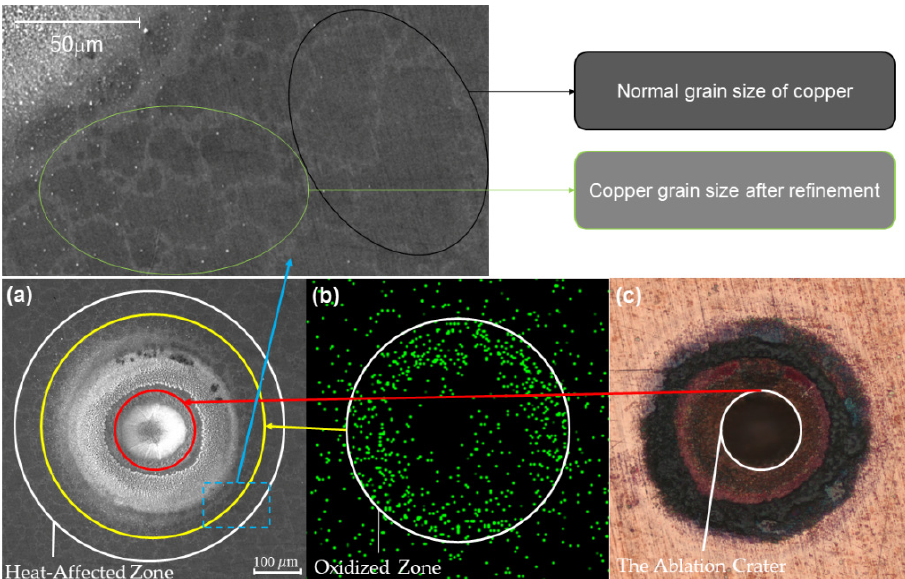
Figure 5. Surface ablation morphology of copper after laser irradiation with energy of 200 μ J, pulse width of 290 fs and pulse number of 1000 (( a ) is SEM image, ( b ) is EDS analysis of oxygen element, ( c ) is optical microscopy photo).